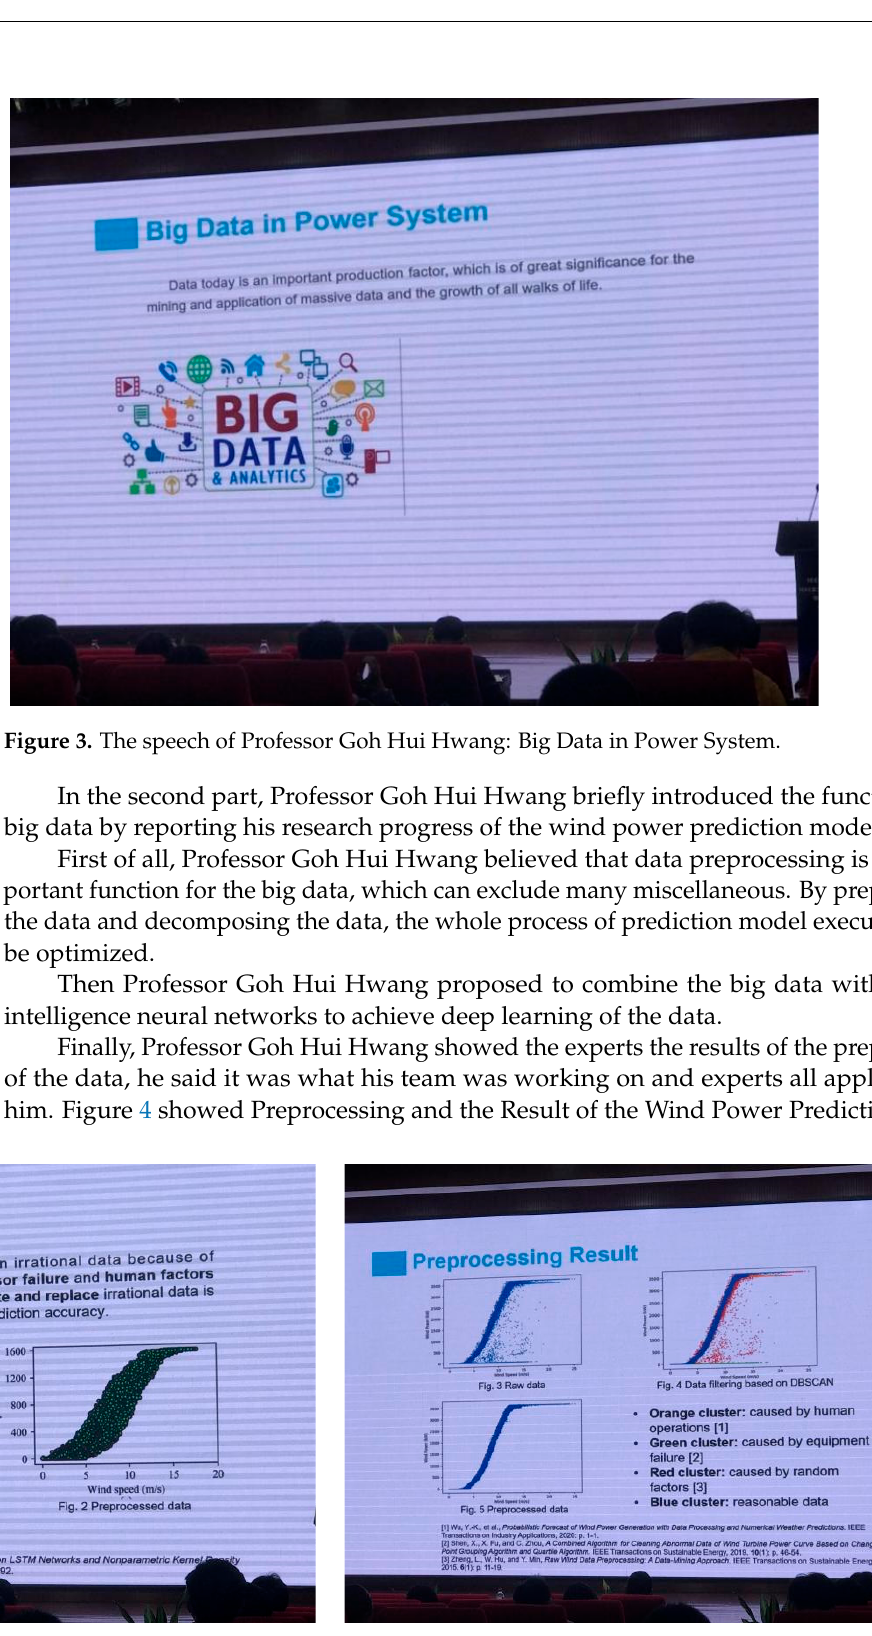
Figure 4. The speech of Professor Goh Hui Hwang: Preprocessing and the Result of the Wind Power Prediction Model.